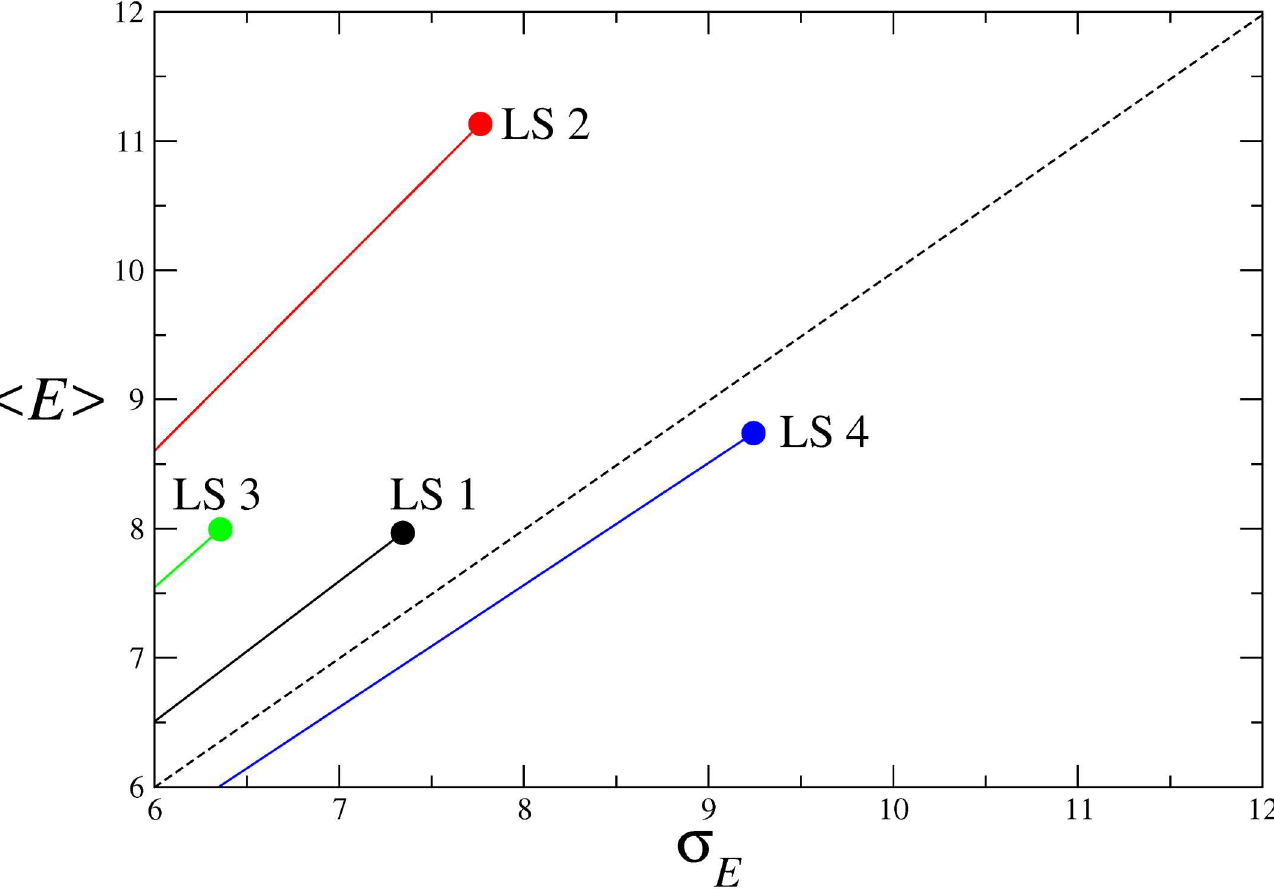
Fig 4. The efficiency of leadership systems. Efficiency of leadershipsystems, by evaluatingthe mean-variance of the efficiency E ( t ) (see Eq 4). Points abovethe dashed diagonal,marking < E > = σ E , are the ones havinga statistical significantefficiency. From those one clearly sees that the one evidencinghighermean-variance quotient is LS 2, which therefore can be taken as the best strategy for maximum efficiency.